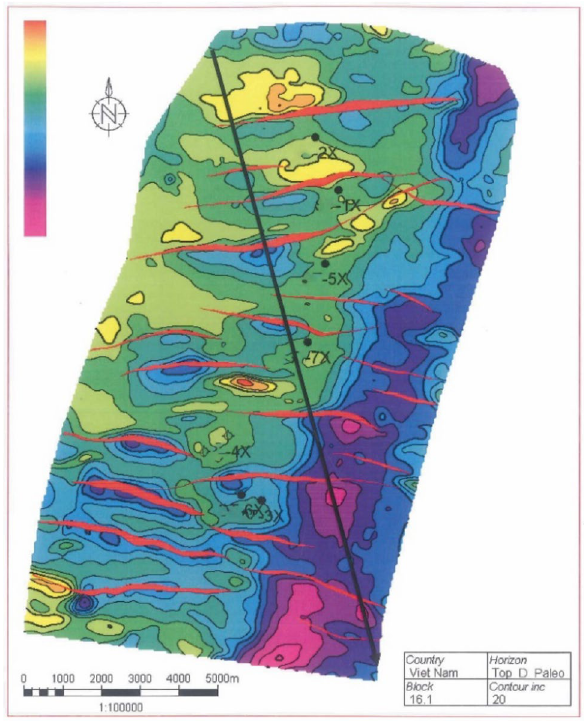
Fig. 1 Topography map of early formation period of C reservoir Fig. 2 Topography map of late formation period of C